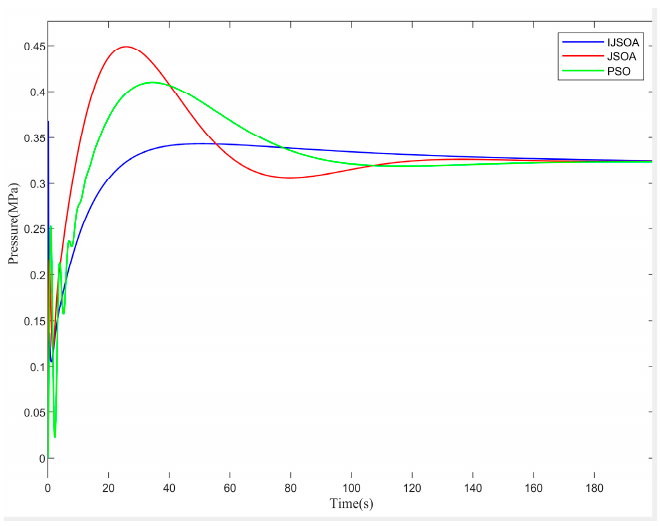
Figure 10. Comparison of pressure control effect.